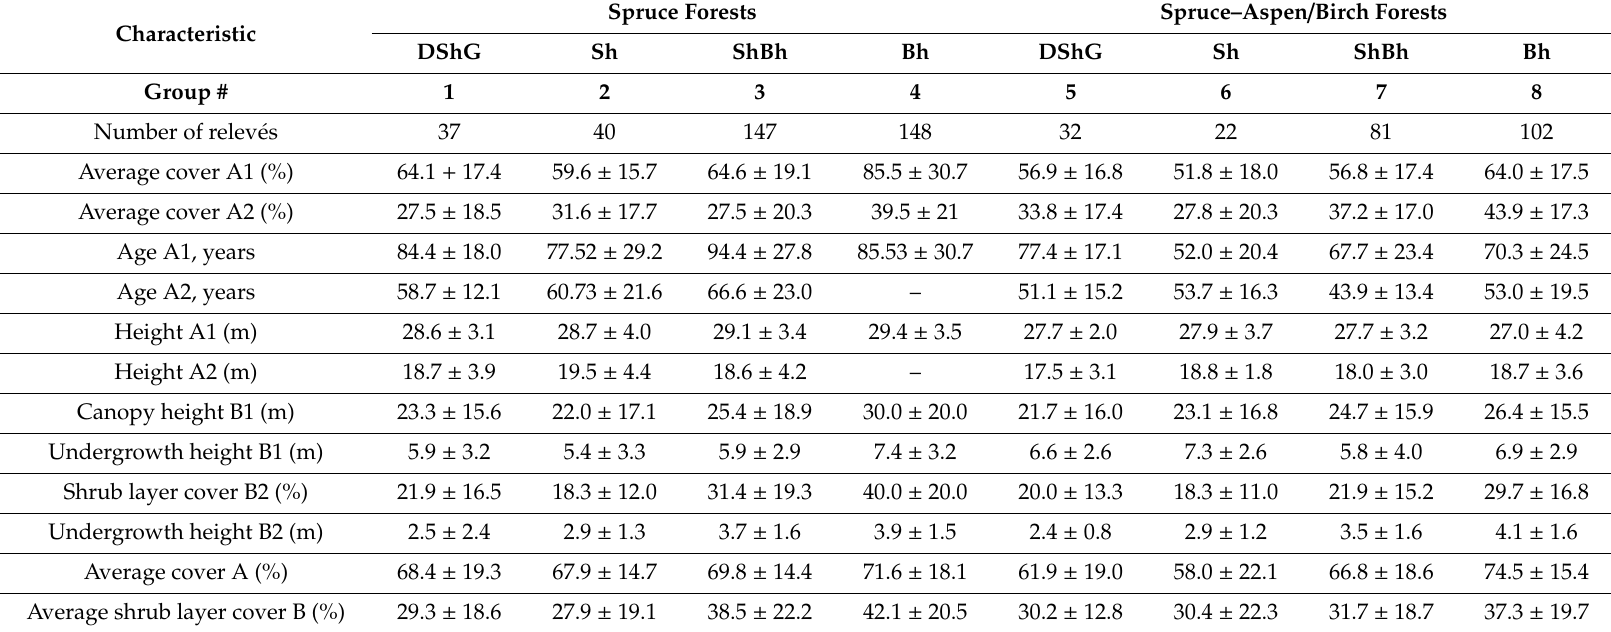
Table A3. Dendrometric characteristics of spruce and spruce–aspen / birch communities. Spruce Characteristic